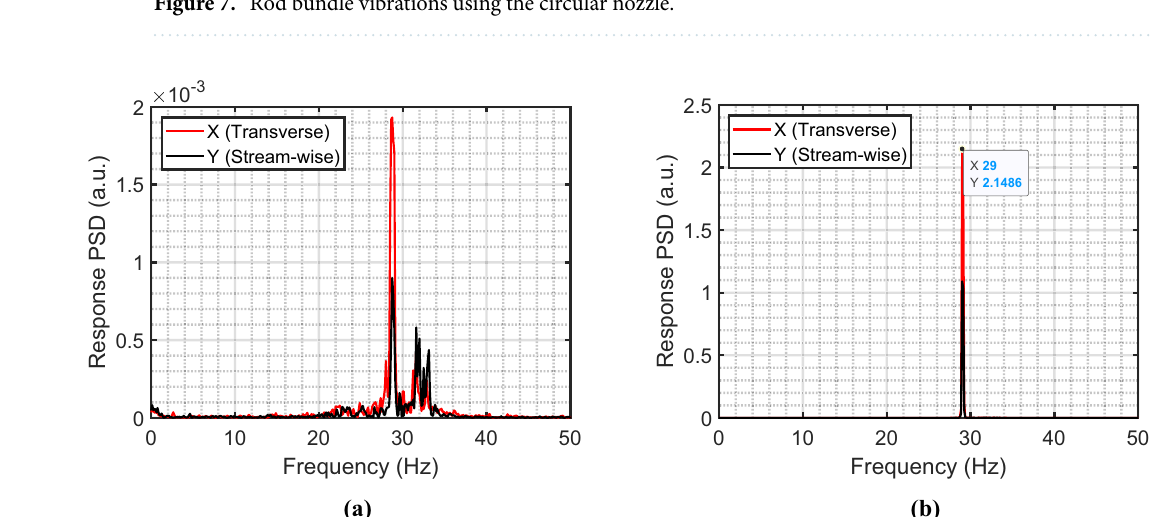
Figure 8. ( a ) PSD plot for Rod 401 at V Jet = 1.45 m/s, and ( b ) PSD plot for Rod 401 at V Jet = 1.75 m/s.